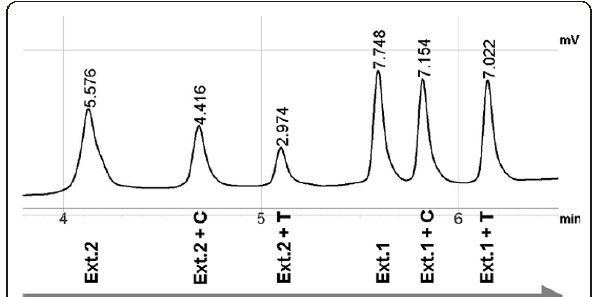
Figure 2 A SNuPE IP RP HPLC example showing the discrimination of extension primer only vs. extended primer oligonucleotides (T with higher molecular weight than C) . Methylation levels can be calculated by comparison of the relative heights of Ext.+C (formerly methylated cytosine) and Ext.+T (formerly unmethylated cytosine). Differences in length and composition of the two extension primers allowed discrimination of two separate extension primer sets (Ext.1 and Ext.2) within one SNuPE